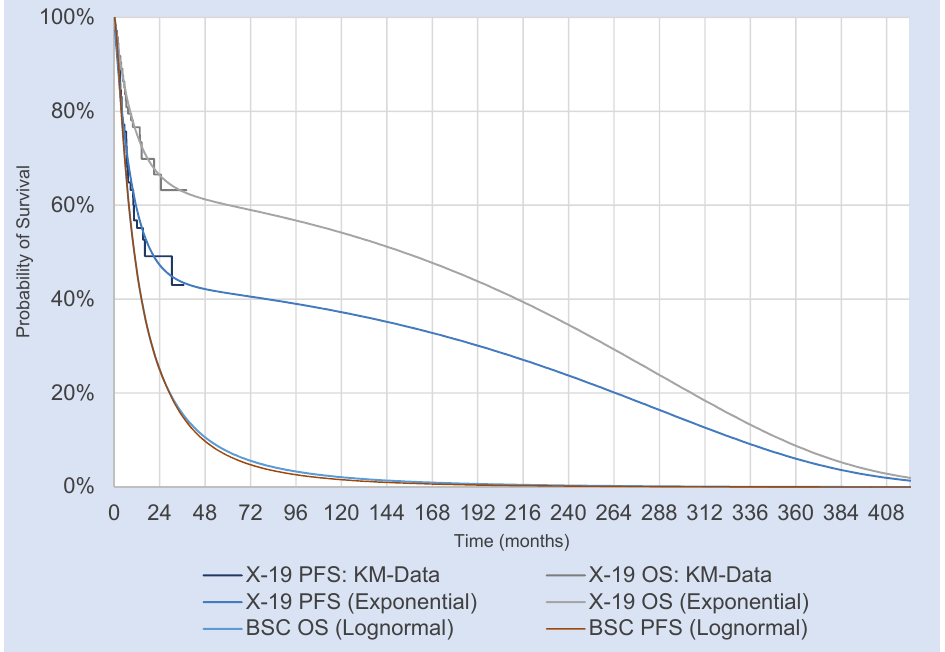
Figure A2. Mixture cure parametric model extrapolations fitted to overall survival and progression- free survival data of brexucabtagene autoleucel (data from ZUMA-2 trial) and BSC (data from meta- analysis) . Data derived from ZUMA-2 trial (Brexu-cel) and meta-analysis (BSC). Abbreviations: PFS: progression-free survival; OS: overall survival; ITT: intent-to-treat population; KM: Kaplan–Meier; PS-MCM: partitioned survival mixed cure model. Table A1. Summary of health state resource use frequency, based on Canadian Clinical Expert feed- back.